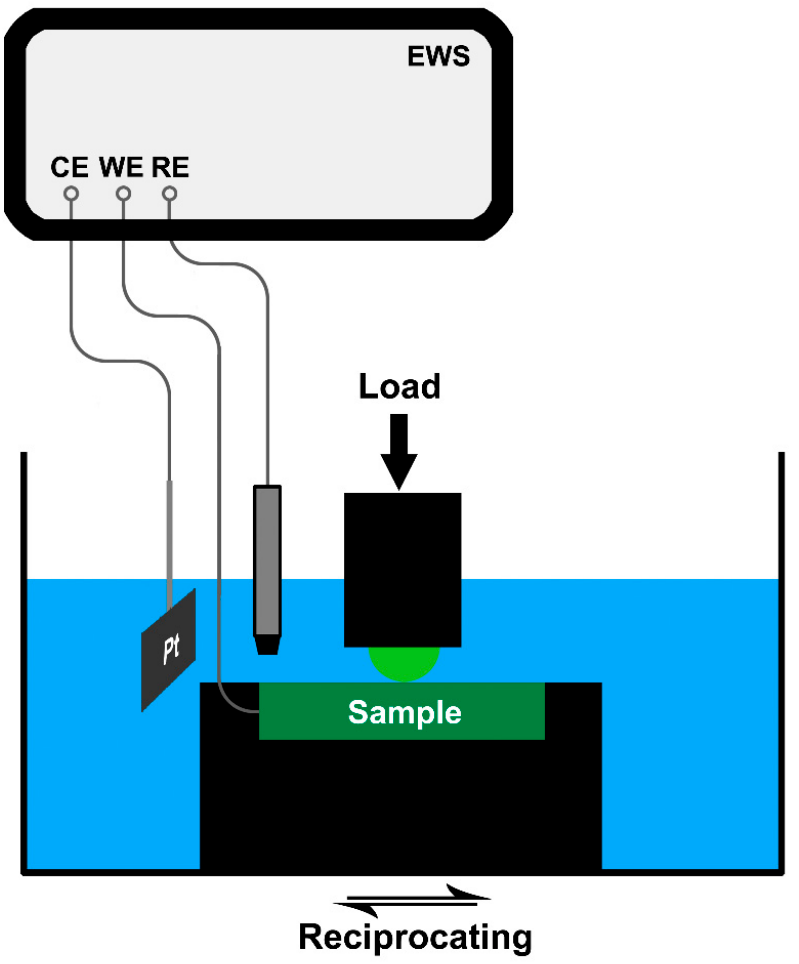
Figure 1. Schematic illustration of the tribocorrosion test